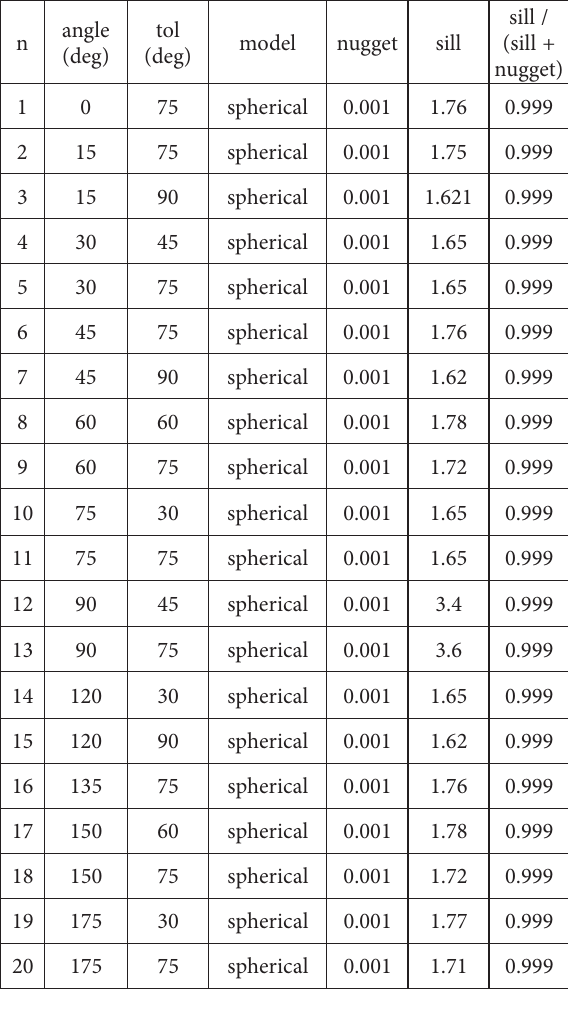
Table 1. Parameters of best variogram for porosity